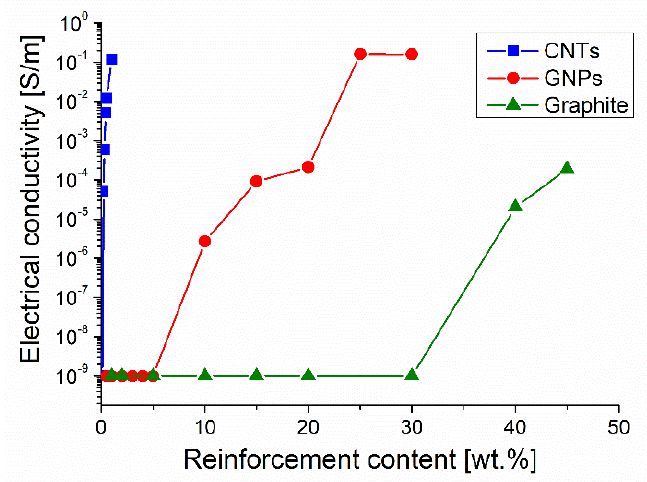
Figure 3. E ff ect of the filler content on the electrical conductivity of Figure 3. Effect of the filler content on the electrical conductivity of composites.